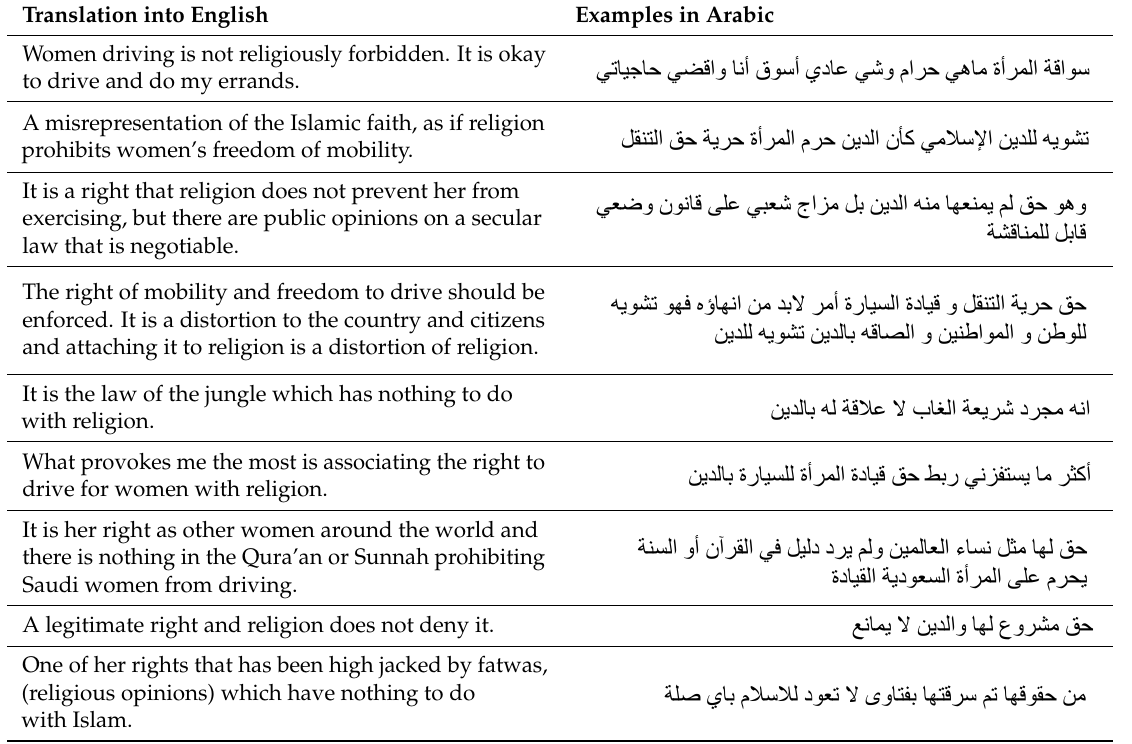
Table 1. Examples of normalizing women driving through Islamic discourse. Translation into English Examples in Arabic Women driving is not religiously forbidden. It is